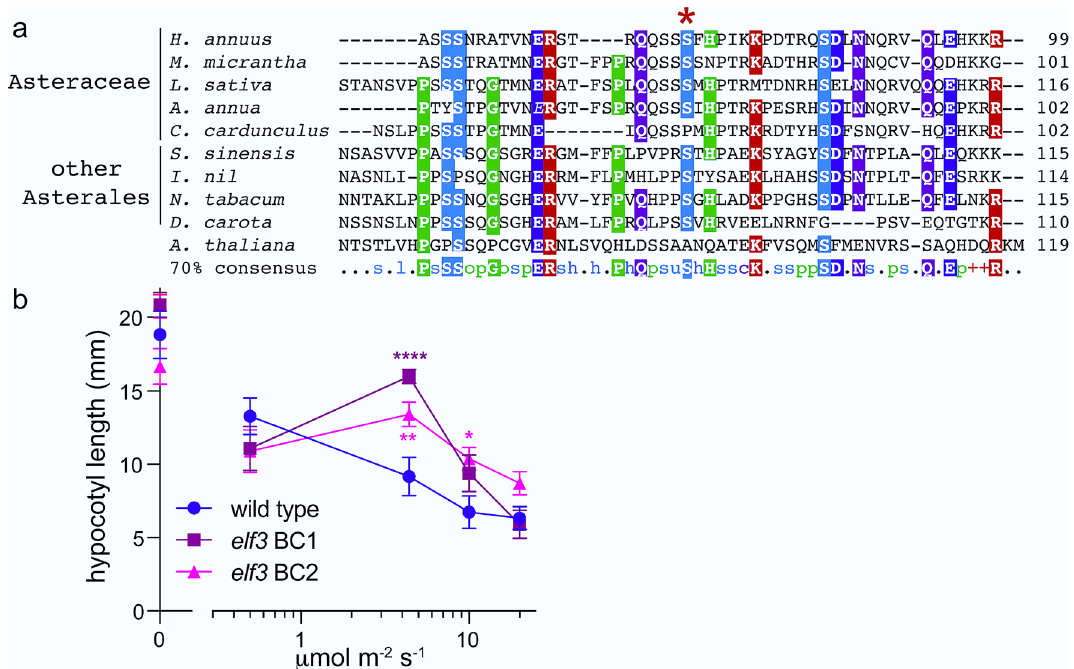
Figure 5. (a) Sequences of the predicted proteins most similar to HaELF3_3 from the indicated species. Starred residue corresponds to S73 in HaELF3_3. ( b) Hyposensitivity to light in sunflower with an induced variant in HaELF3_3 . Seedlings were maintained in constant darkness or monochromatic red light of the indicated fluence rates for 10 days and then hypocotyl length was measured. BC1 and BC2 represent homozygous populations of elf3_3 S73F plants backcrossed once or twice, respectively, to the parental genotype. Mean ± SEM is plotted. Significance assessed using t-tests with FDR correction; **** < 1 e−4, ** < 1 e−2, * <